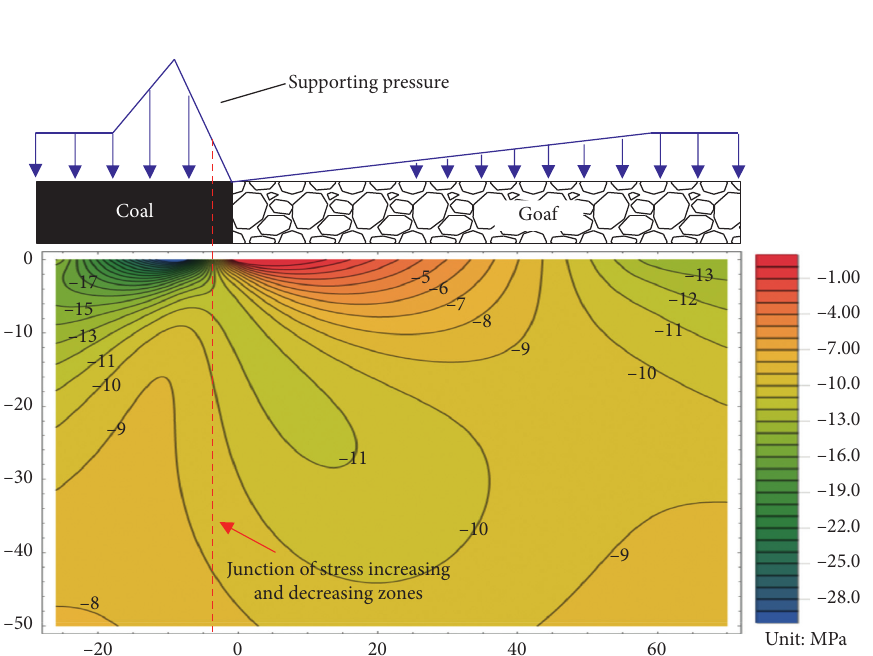
Figure 6: The horizontal stress